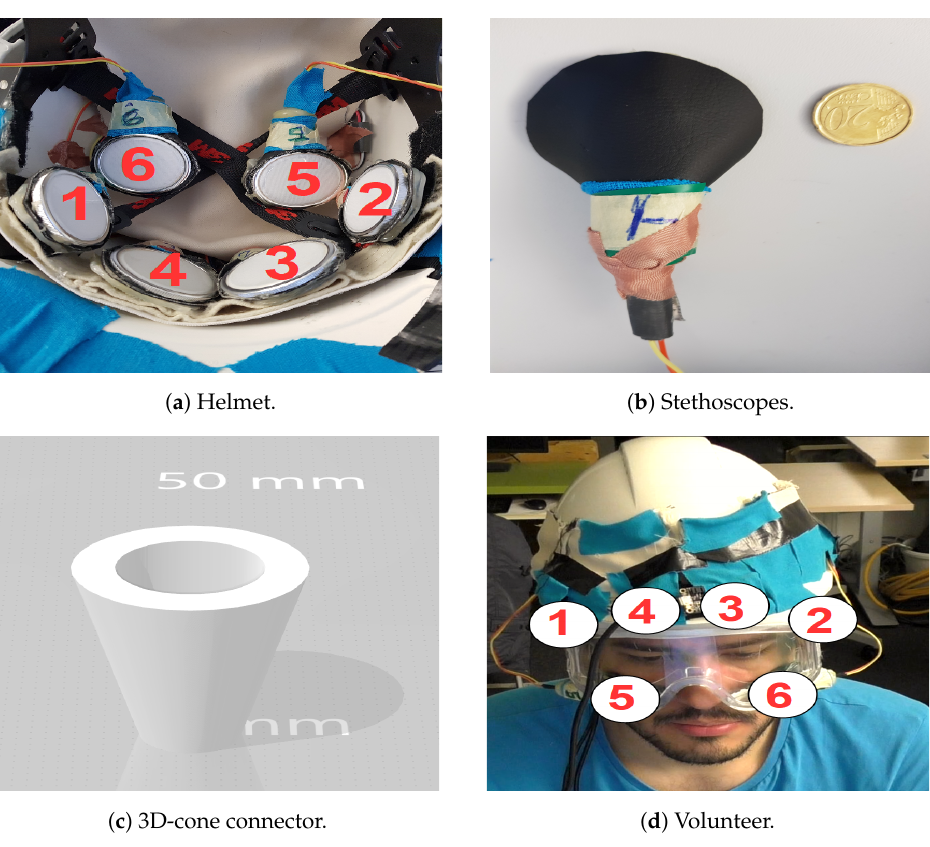
Figure 9. ( a ) Helmet inside, four fixed stethoscope-microphone in elastic-band and two loose. ( b ) Back side of stethoscope head with leather cover and size comparison. ( c ) Three-dimensional (3D) cone connector between Electret microphone and nurse stethoscope head. ( d ) Stethoscope-microphone on the face of volunteer using construction helmet and goggles.